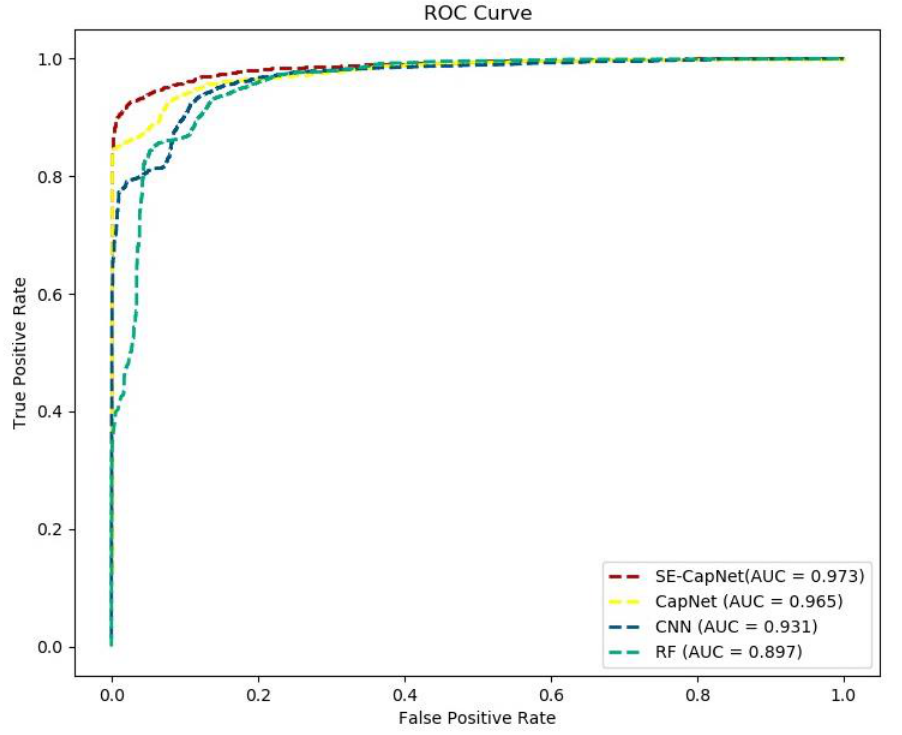
Figure 10. ROC Figure 10. ROC Curve.